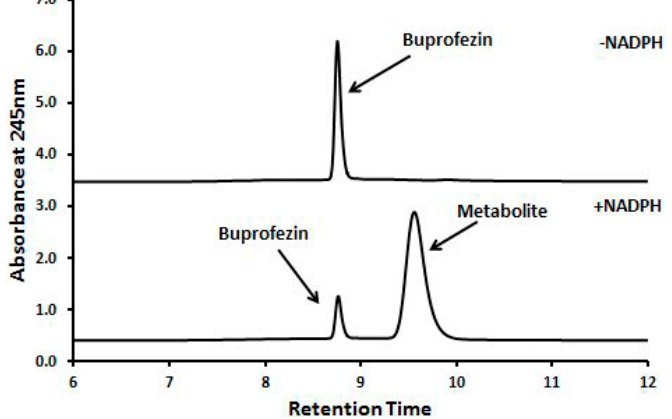
Figure 3. Metabolism of buprofezin by CYP353D1v2. Buprofezin depletion (eluting at 8.7 min) and metabolite formation (eluting at 9.5 min) observed after incubating the insecticide with the microsome preparation. Incubations carried out in the absence of an NADPH regenerating system showed no change when compared with the control chromatogram of the parental buprofezin.